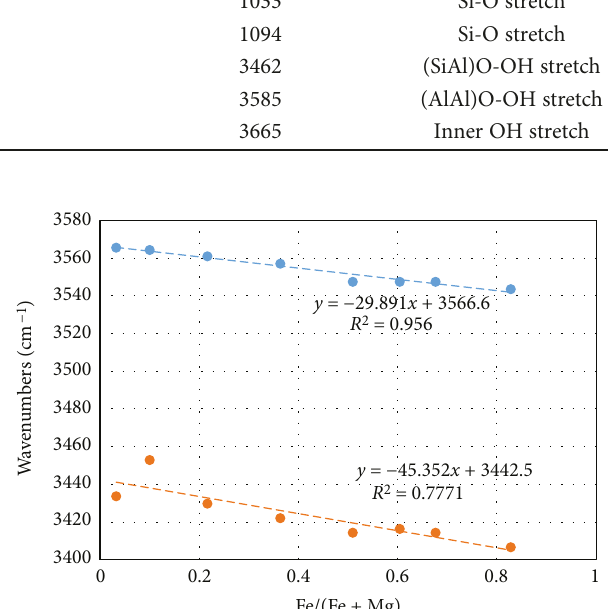
Figure 3: Correlation between the chlorite fundamental bands and Fe/(Fe +Mg)